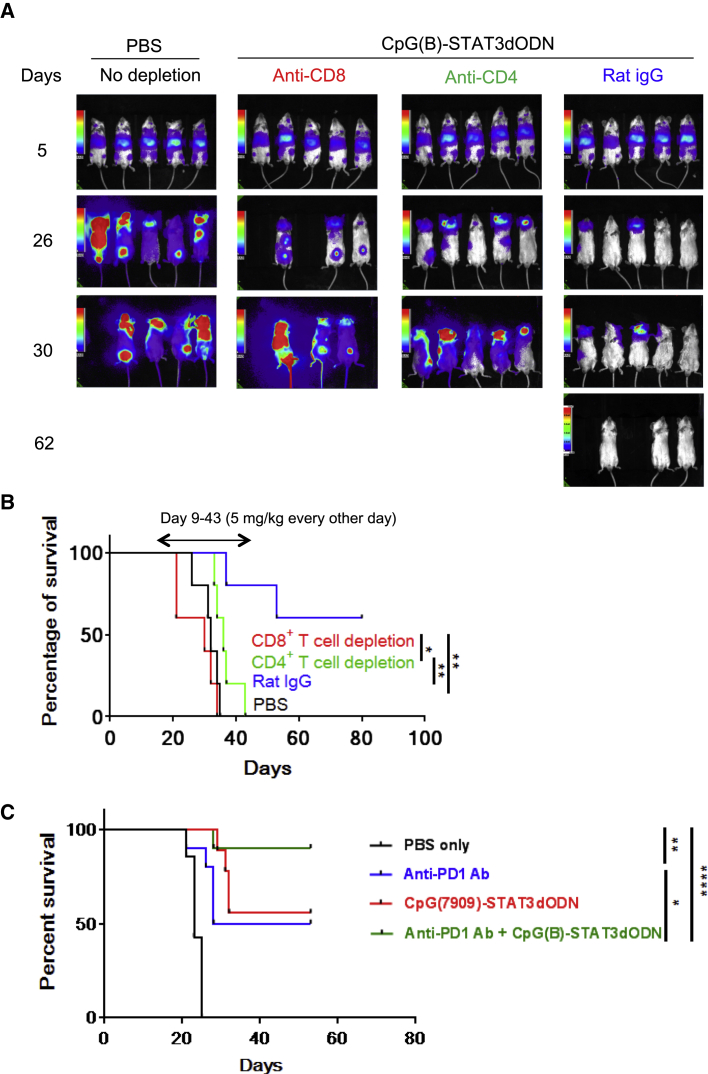
Therapeutic Effect of CpG(B)-STAT3dODN against BCL Relies on T Cell Activity and Can Be Augmented by Combination with PD1 Blockade(A and B) CD8+ and CD4+ T cell populations were depleted in mice engrafted with A20LUC lymphoma using 200 μg i.p. anti-CD8 (2.43), anti-CD4 (GK1.5), or control rat IgG (Sigma-Aldrich) at day 6, day 8, and then once a week for the rest of the experiment. Starting from day 9, mice were administered an intravenous injection using 5 mg/kg CpG(B)-STAT3dODN every other day. (A) Lymphoma burden was monitored using BLI; shown are the representative images. (B) Combined results showing Kaplan-Meier survival curves for the indicated treatment groups (n = 5 per group). IgG, immunoglobulin G. (C) Mice with established systemic A20LUC lymphoma were treated using CpG(B)-STAT3dODN (5 mg/kg, every other day from day 9) and anti-PD1 antibody (eBioscience; 200 μg i.p.) injected alone or in combination. Kaplan-Meier survival curves are shown for the indicated treatment groups (n = 10 per group, except for PBS: n = 7). *p < 0.05, **p < 0.01, ****p ≤ 0.0001.